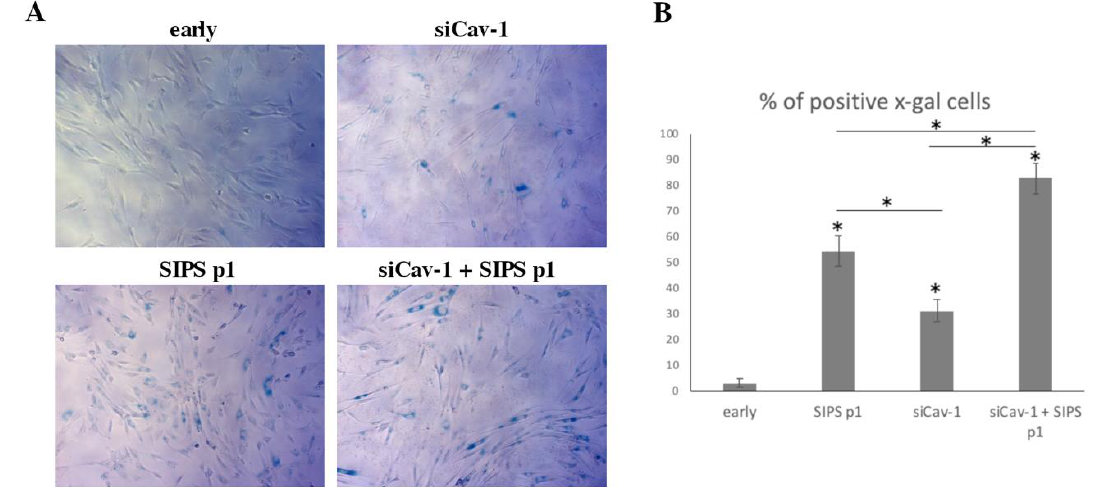
Figure 7. Cav-1 downregulation results in accelerated SIPS. ( A ) Representative photos of early passage WJ-MSCs (early), early passage WJ-MSCs treated with siRNA against caveolin-1 (siCav-1), early passage cells after being subjected to stress induced premature senescence (SIPS) at passage 1 (SIPS p1) and early passage WJ-MSCs treated with siRNA against caveolin-1 after being subjected to stress induced premature senescence (SIPS) at passage 1 (siCav-1+SIPS p1), stained with SA- β -gal staining solution. ( B ) Graph showing the percentage of SA- β -gal positive cells in early, SIPS p1, siCav-1 and siCav-1+SIPS p1 WJ-MSCs. p values shown are the means ± S.E. * p < 0.05 vs. early passage or otherwise indicated. p values calculated using the Student t -test .